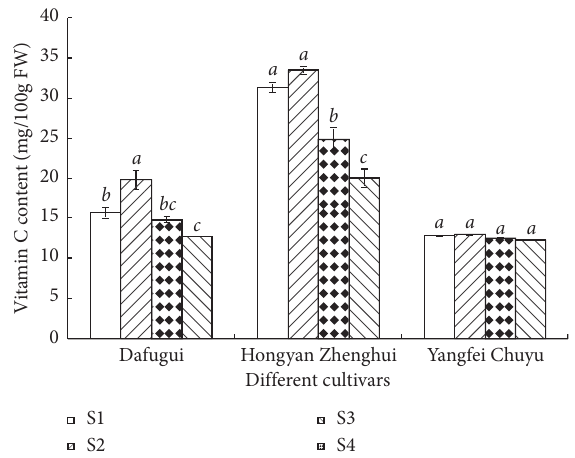
Figure 5: Vitamin C content of developmental P. lactiflora petals (mg/100 g FW). Different letters within each cultivar indicated significant differences at 5% level.